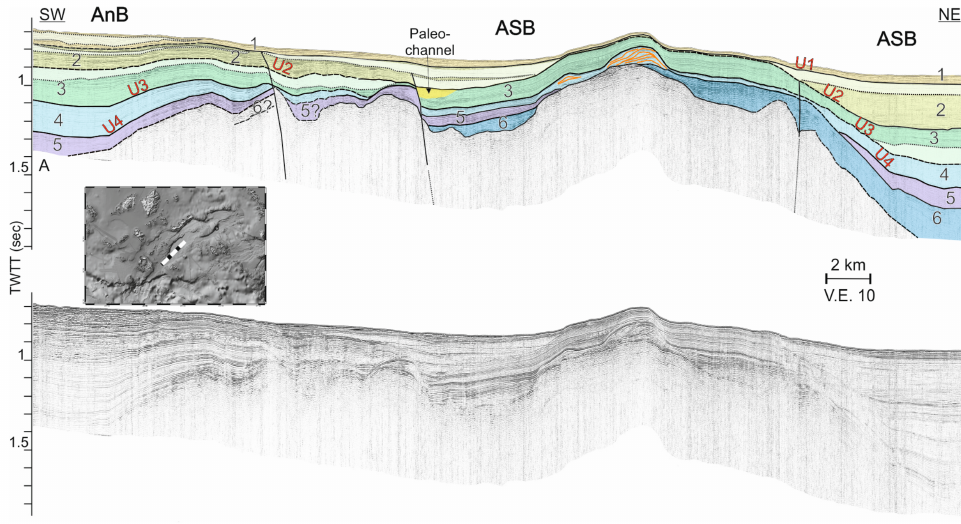
Figure 10. Airgun 40 ci seismic profile along Anafi Basin (AnB) and Amorgos South Basin (ASB) in SW-NE direction (along strike). Terminology and symbols as in Figure